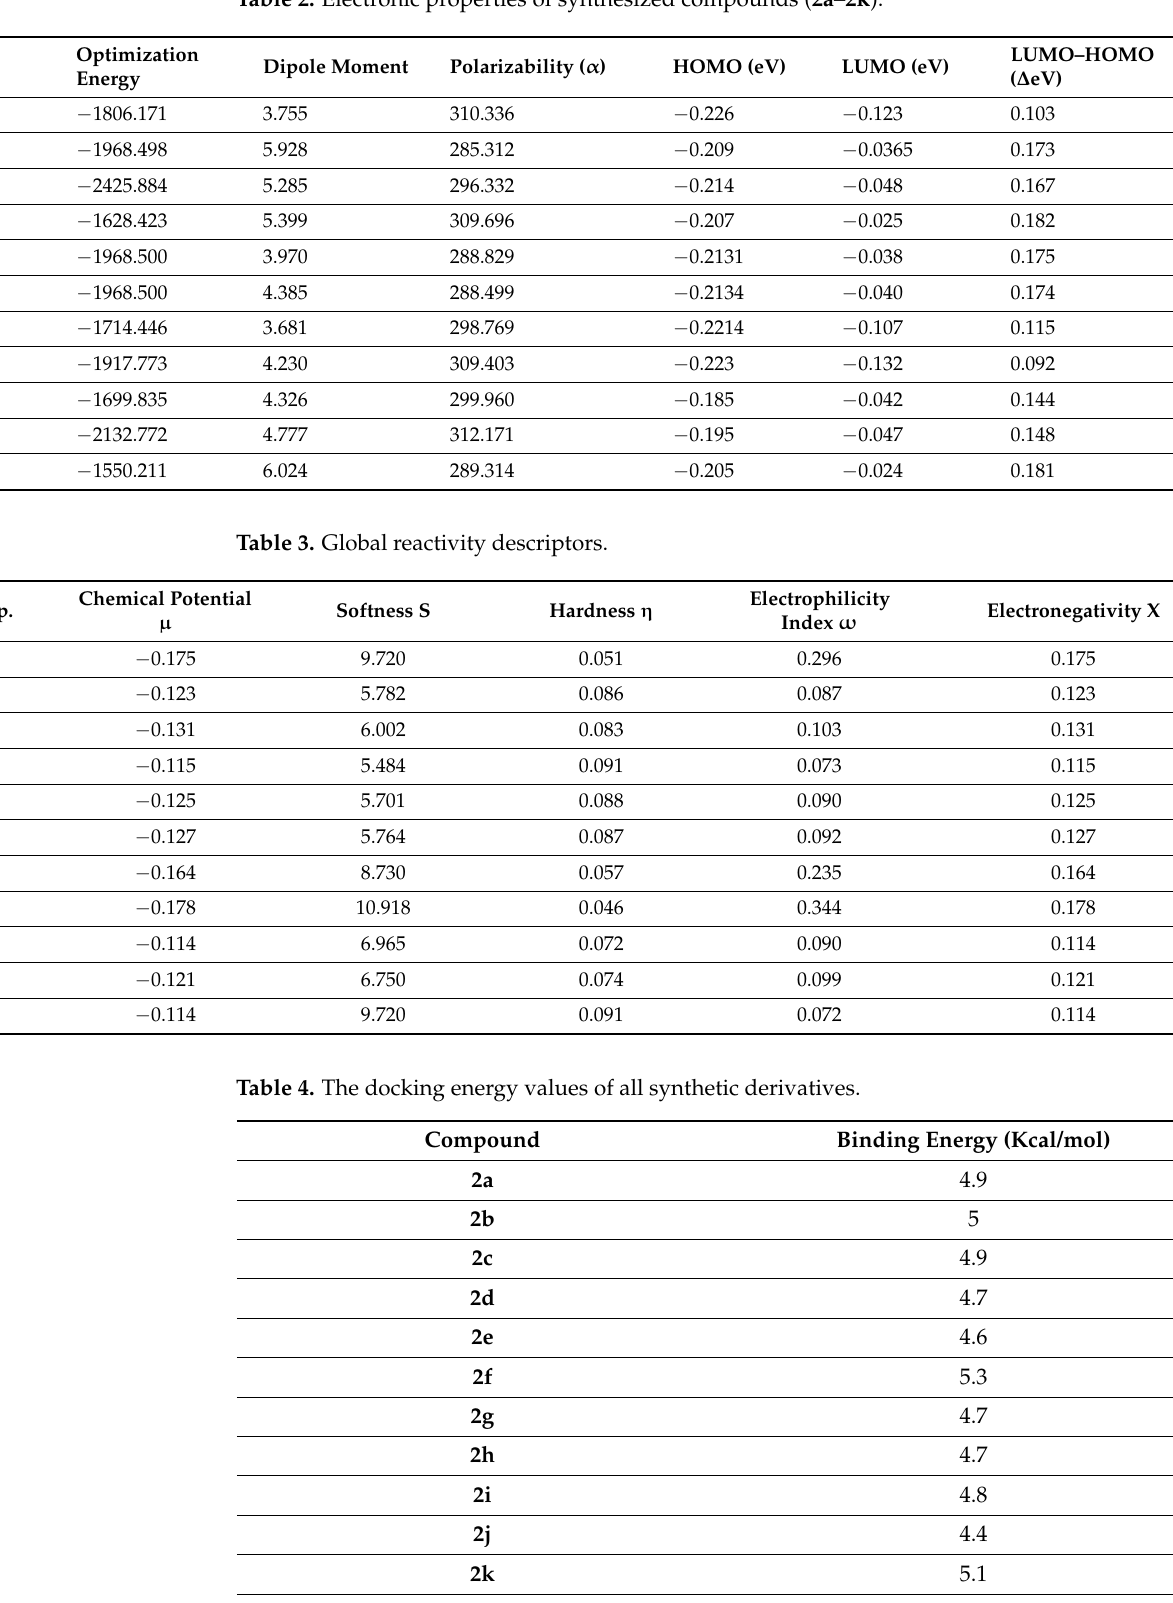
Table 2. Electronic properties of synthesized compounds ( 2a – 2k ).